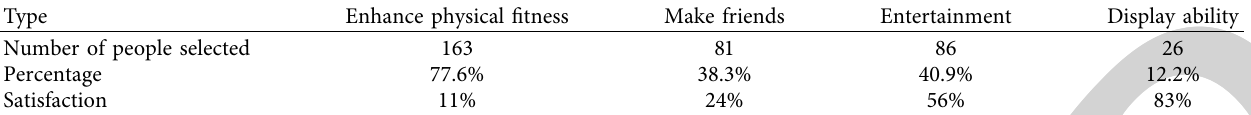
Table 2: Motivation for participation in sports for the elderly in urban communities ( n � 210).